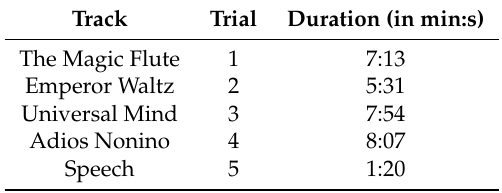
Table 2. Track lengths and their correspondence with the trial